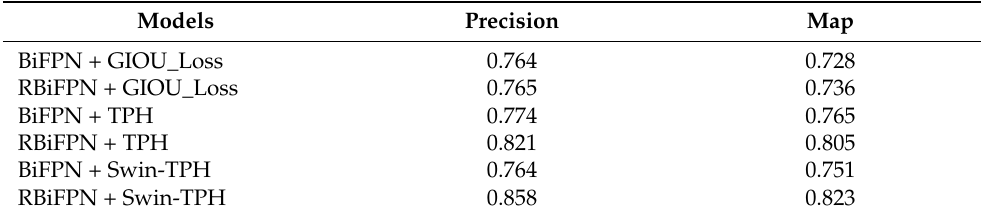
Table 2. Comparision of